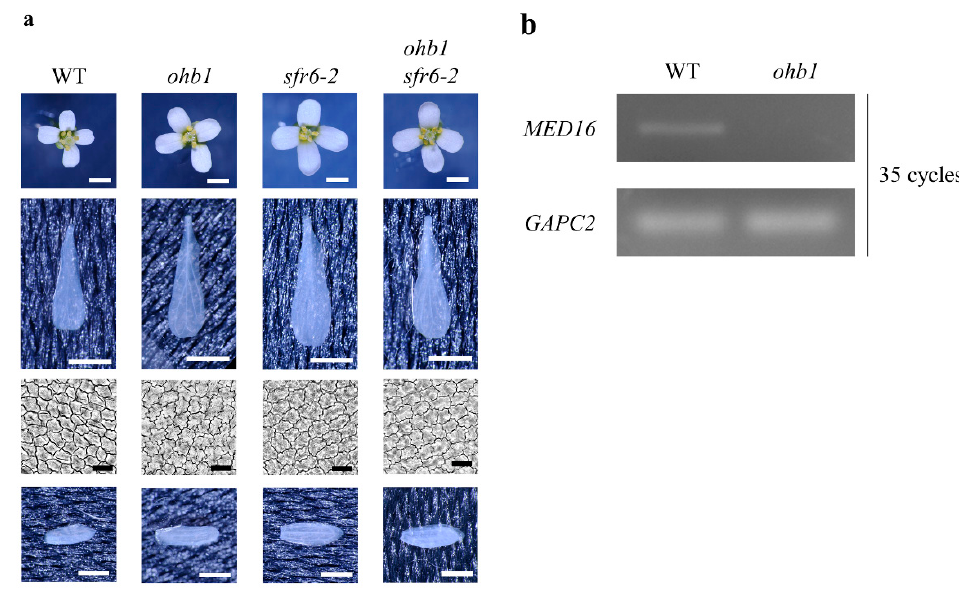
Figure 1. Characteristics of ohb1 mutant. ( a ) Flower phenotypes of the WT, ohb1 , sfr6-2 , and ohb1 sfr6-2 plants. The whole flowers, petals, petal abaxial epidermal cells, and sepals in each line are shown. White and black bars represent 1 mm and 20 μ m, respectively. ( b ) RT-PCR analysis of MED16 expression in WT and ohb1 . The transcript amount of GCP2 was used as an internal control in the RT-PCR. Table 1. List of candidate mutations responsible for the large flower phenotype shown by the ohb1 mutant. Chr.